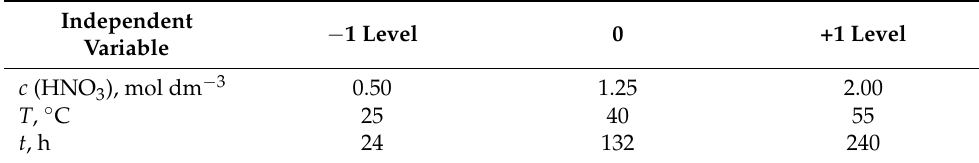
Table 2. Factors used in the Box–Behnken